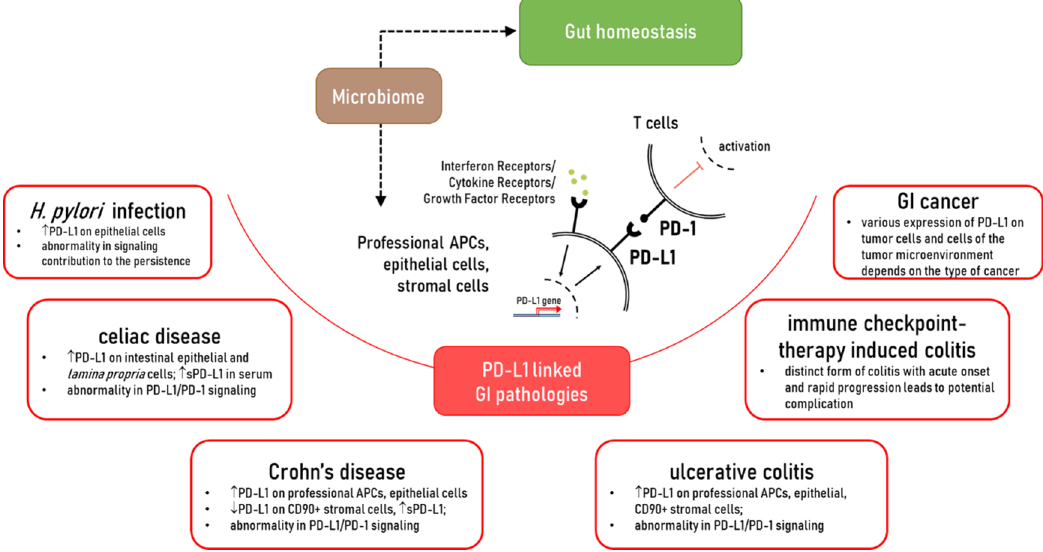
Figure 1. The role of PD-L1 in the gut homeostasis and pathologies which affected PD-L1 expression and/or PD-L1/PD-1 signaling.